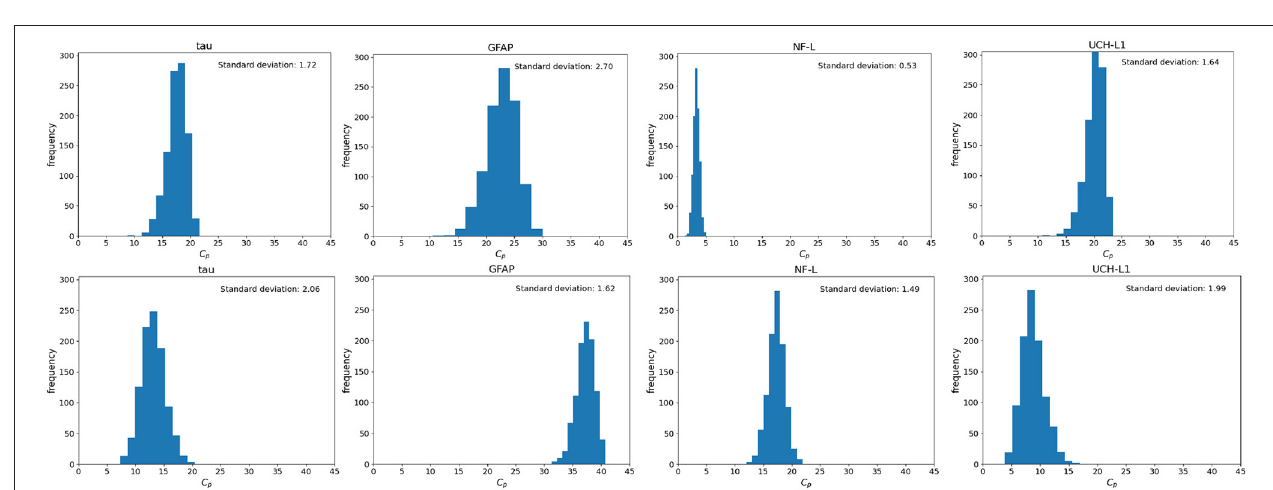
FIGURE 8 | Monte Carlo simulations to investigate the effect of uncertainty in time on the blood biomarker levels ( C p ). Simulations were conducted by setting the model parameters to the nominal values in Table 1 and the initial biomarker released to D 0 = 400,000 pg. (Top) Histograms of blood biomarker levels at 6 h, with time varying in a range of (3, 12). (Bottom) Histograms for blood biomarker levels at 36 h, with time varying in the range of (35, 56). Note that at 36 h, biomarker levels of GFAP and NF-L are still rising while levels of tau and UCH-L1 are falling.